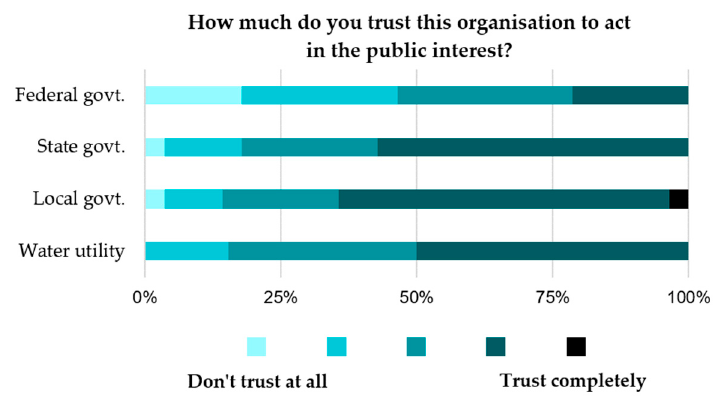
Figure 4. Community champions rating of organizational trust for acting in the public interest.